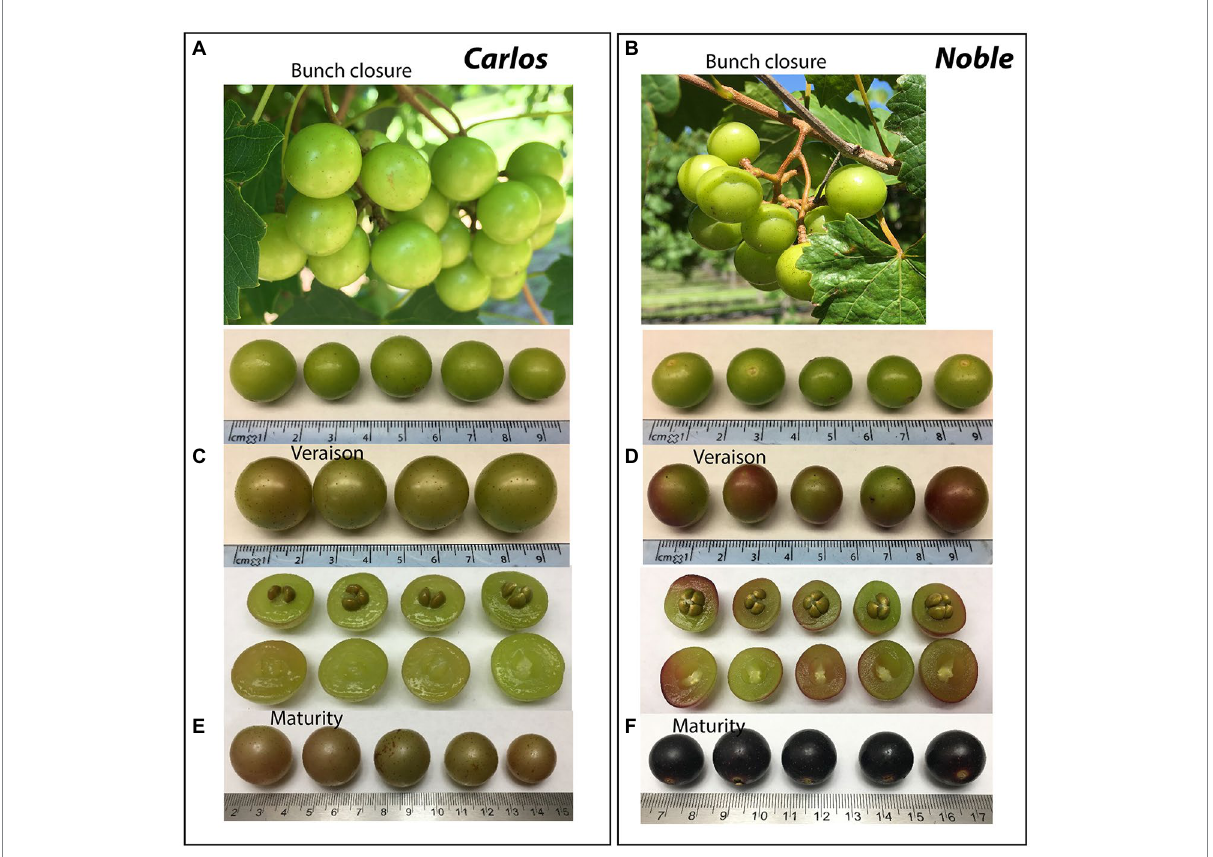
FIGURE 1 Representative images of muscadine grape genotypes during ripening. The photographs show the muscadine grape berries of “Carlos” on the left (A,B,C) and “Noble” on the right (D,E,F) at bunch closure (E-L 32), veraison (E-L 35), and maturity stage (E-L 38),